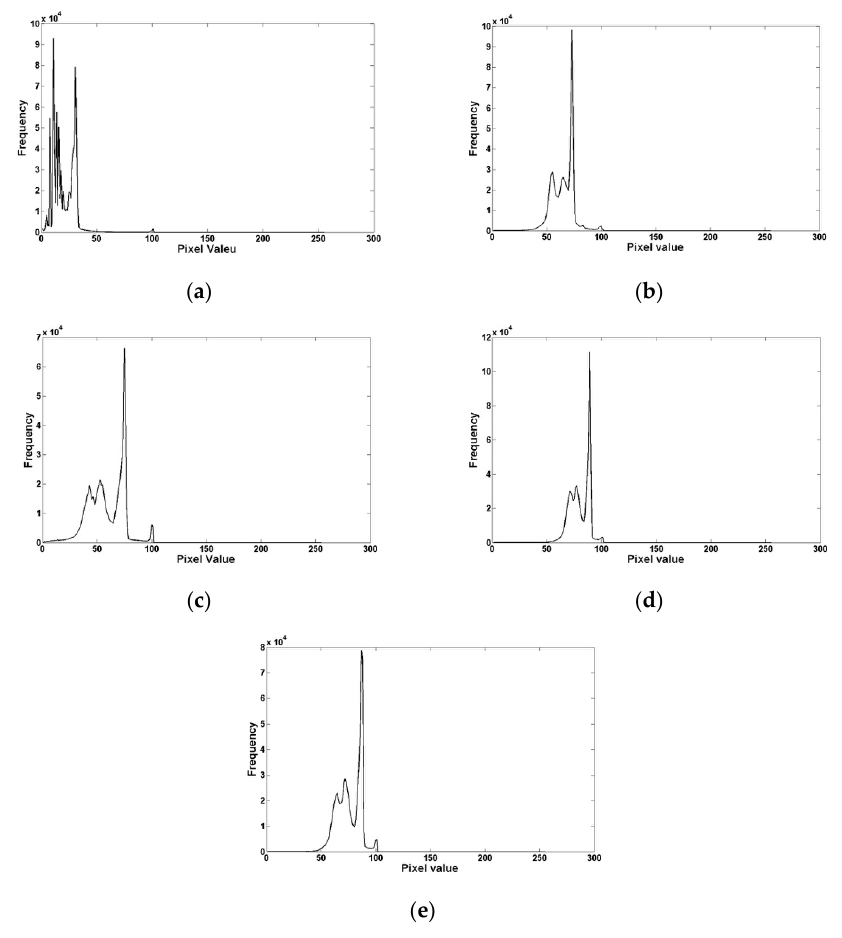
Figure 9. Histograms of Figure 4 images: ( a ) an original image and resulting images of ( b ) iCAM06, ( c ) Reinhard’s method, ( d ) Choi’s method, and ( e ) the proposed method. Appl. Sci. 2019 , 9 , x FOR PEER REVIEW